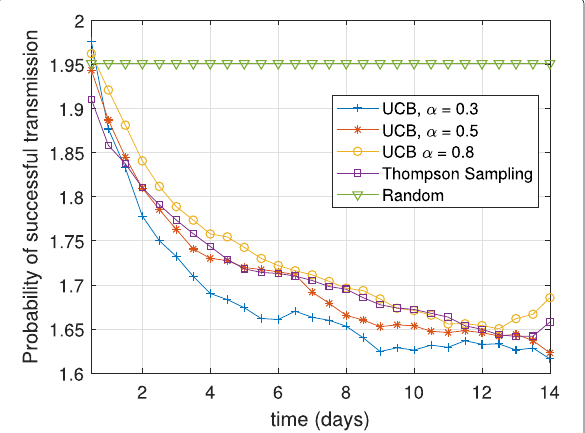
Fig. 16 Evolution of latency with time for different learning